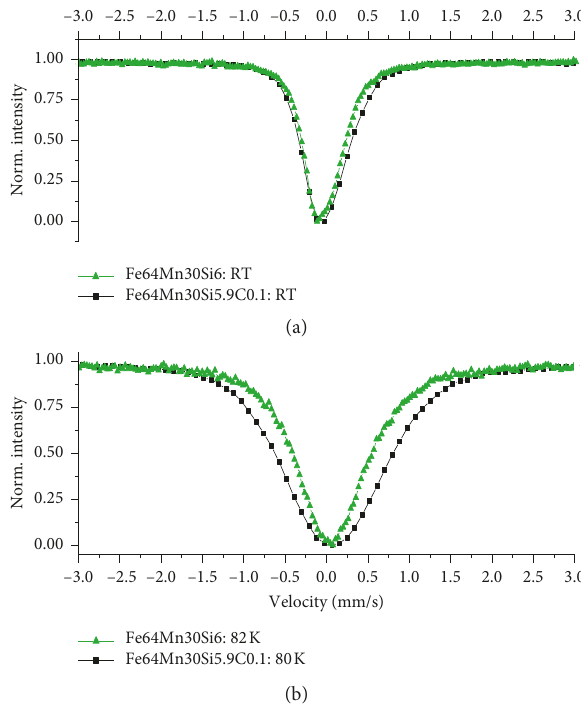
Figure 9: M¨ossbauer spectra: (a) room temperature and (b) 80 K for Fe-30Mn-6Si and Fe-30Mn-5.9Si-0.1C alloys after annealing. Table 3: Isomer shift values at room temperature and 80K.